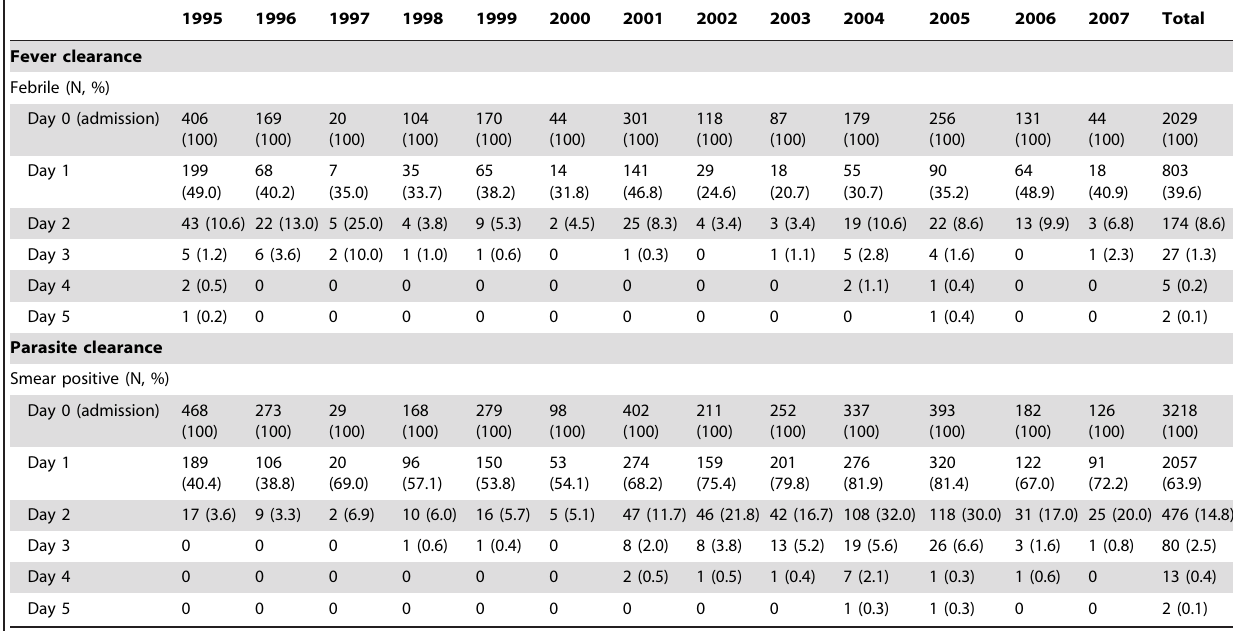
Table 3. Fever and parasite clearance time (in days).